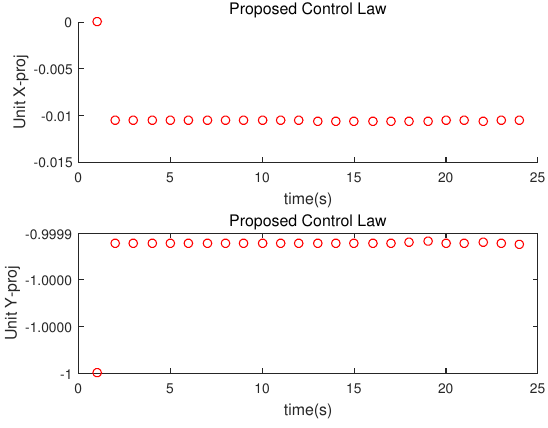
Figure 5. Plot of l for a constant velocity evader.